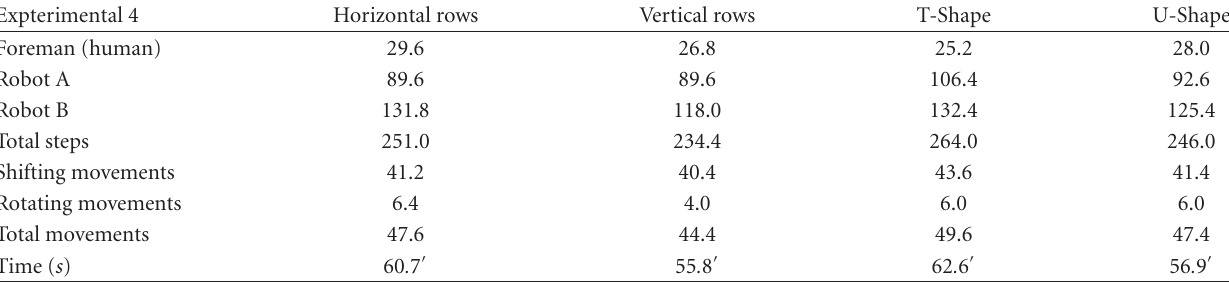
Table 5: Eye-gaze indication of object and target.